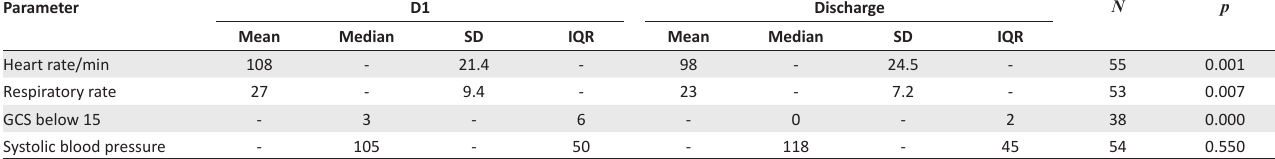
TABLE 3: Clinical characteristics compared from admission (D1) to discharge or death (DC) using Wilcoxon matched pairs test or T -test for dependent samples. Parameter